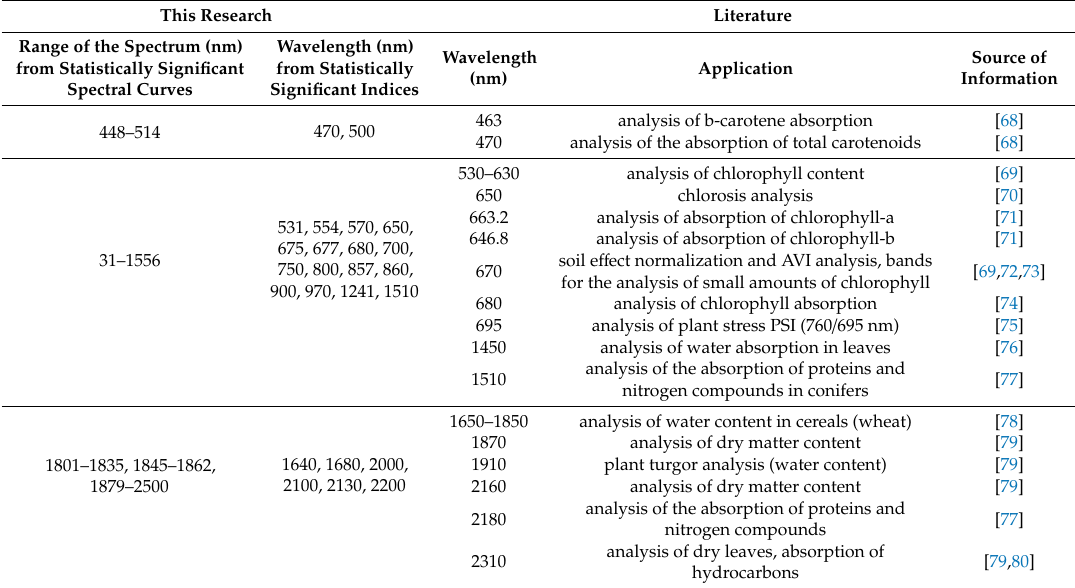
Table 5. Spectrum ranges for vegetation analyses of